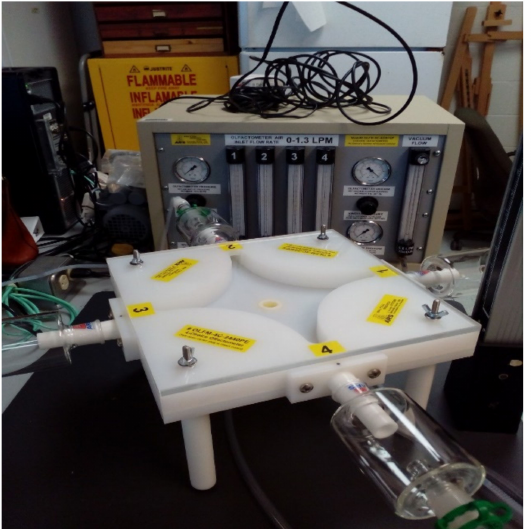
Figure 1. A four-arm olfactometer used to test the olfactory response of E. floridanus to odor from maize leaf